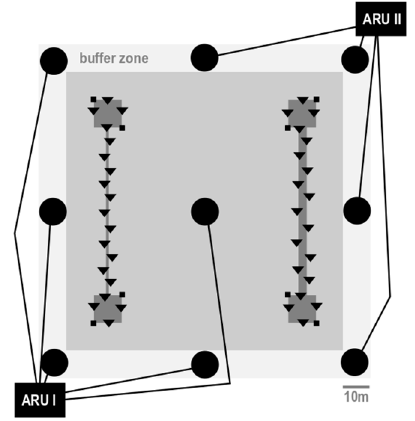
Figure 1. Configuration of corridor systems in grassland with corridors and patches. Black boxes = ARUs (automated receiving units for telemetry); black circles = omnidirectional antennas; black lines = antenna cables. Black triangles = stationary traps; small black squares = calibration transmitters; dark grey squares and rectangles = corridor systems; light grey = matrix area within the experimental site; very light grey buffer zone = matrix outside the experimental site. Corridor systems were 70 m apart and separated by a mown matrix, corridors were 60 m long.